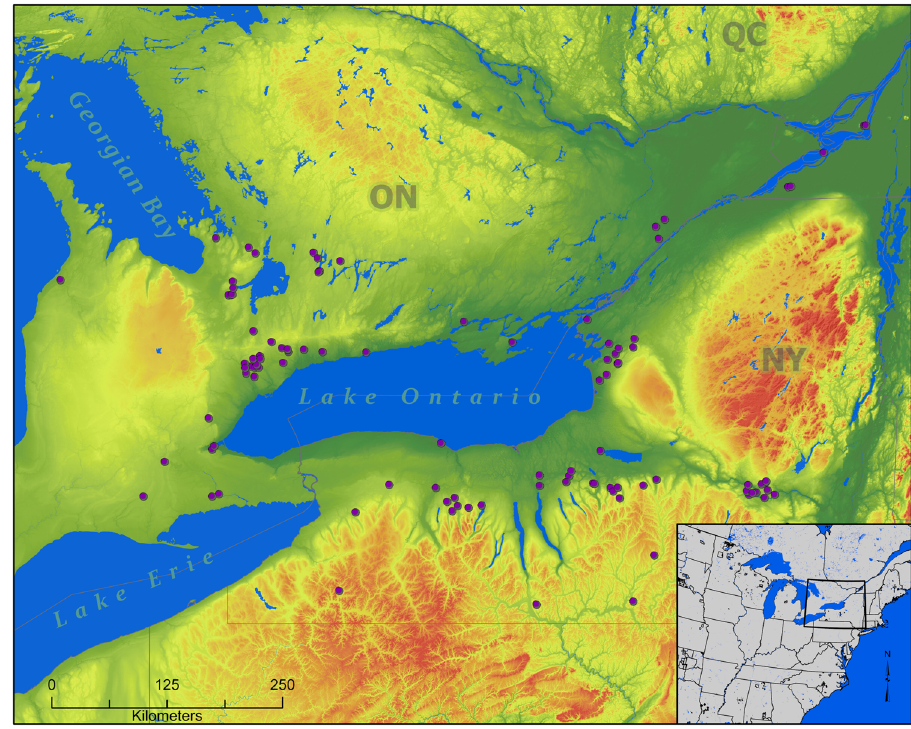
Figure 1: Locations of archaeological sites with radiocarbon dates used in the summed probability distribution